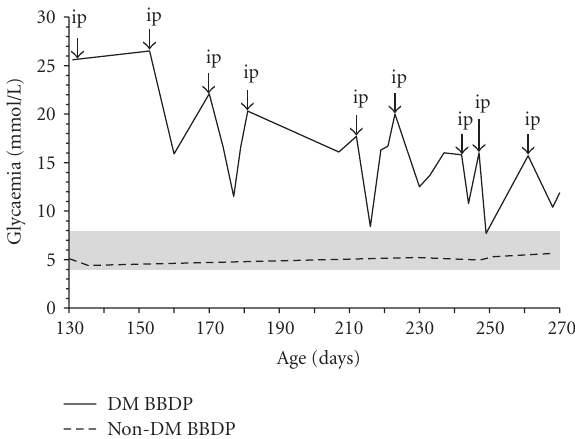
Figure 1: Oscillations in blood glucose levels in a representative diabetic (DM) BBDP rat treated with insulin pellets implanted subcutaneously. During a follow-up period of 140 days the DM BBDP rat received multiple insulin pellet implants (ips) guided by rapid development of hyperglycaemia (solid line) and drop in body weight (not shown). For comparison, glucose levels in an age- matched thymectomized non-DM BBDP rat are shown. The grey area indicates the normoglycaemic range